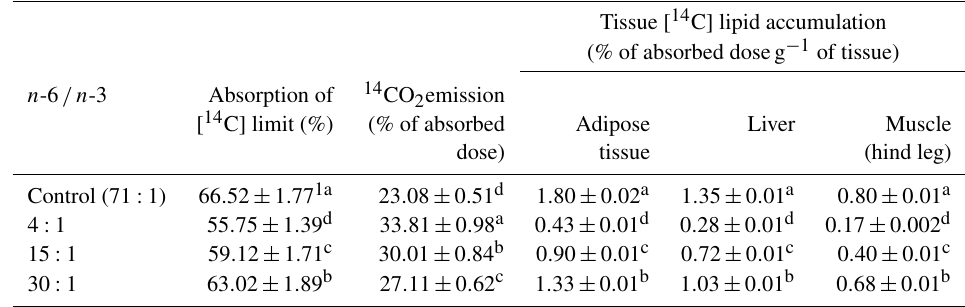
Table 4. 14 CO 2 emission and tissue accumulation of [ 14 C] lipid in jugular-vein-cannulated rats.